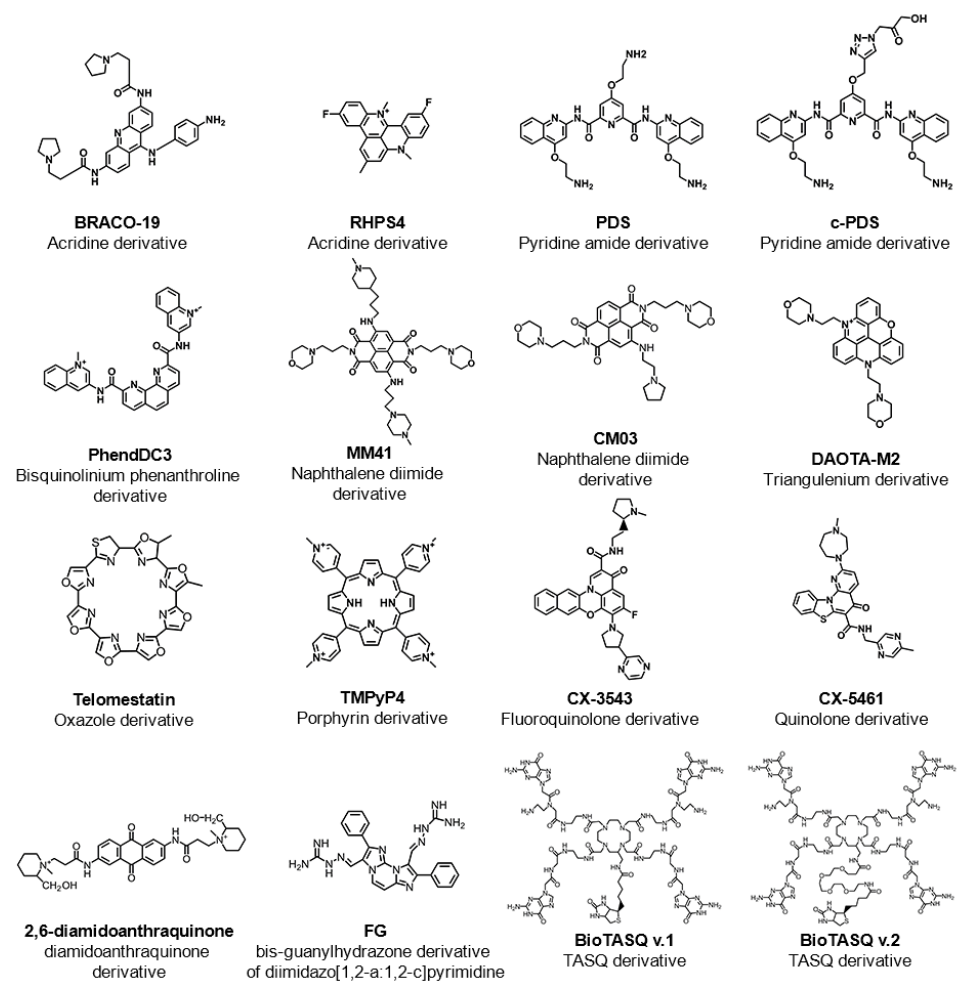
Figure 2. List of some examples of G4-interacting ligands mentioned in this review showing the common name of the ligand, chemical structure and family of the compound (chemical backbone).